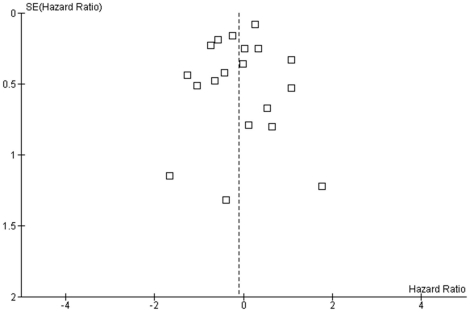
Funnel plot using data from
Figure 3
.Distribution of estimates can be regarded as funnel-shaped and compatible with a moderate publication bias. Abbreviations: SE: standard error.